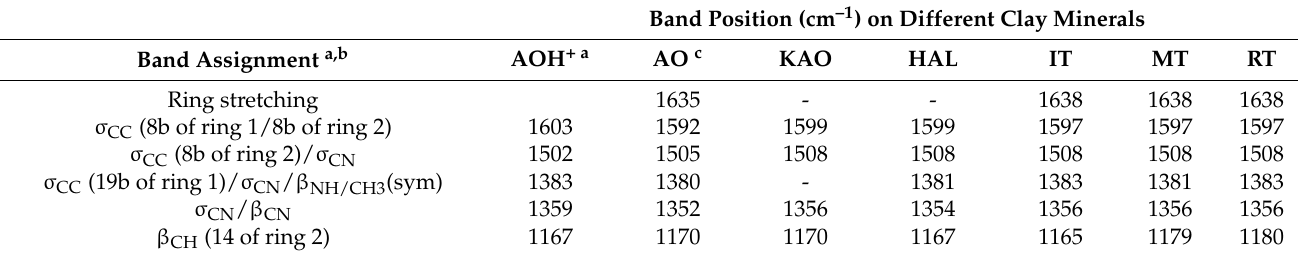
Table 2. Band positions and suggested assignments of AO sorption on different types of clay minerals. Band Position (cm –1 ) on Different Clay